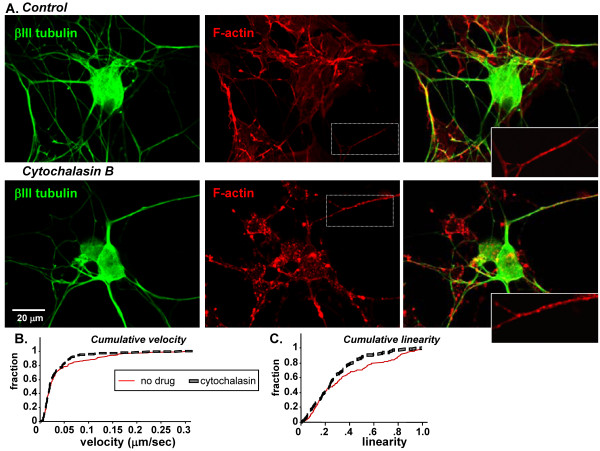
An intact actin cytoskeleton is required for efficient LDCV transport. Trigeminal ganglion neurons were treated with 5 μM cytochalasin B for 1 hour and then fixed and processed for immunocytochemistry (A). Filamentous actin was visualized by staining with a TRITC-phalloidin conjugate (red) and microtubules were stained with an antibody to βIII tubulin (green). Inset: phalloidin staining is shown at higher magnification to illustrate puncta that appeared in cytochalasin-treated neurons. Neurons expressing PHM-GFP were pretreated with cytochalasin B in the same manner before live imaging; cumulative velocity (B) and cumulative linearity (C) were plotted as in Figure 3.